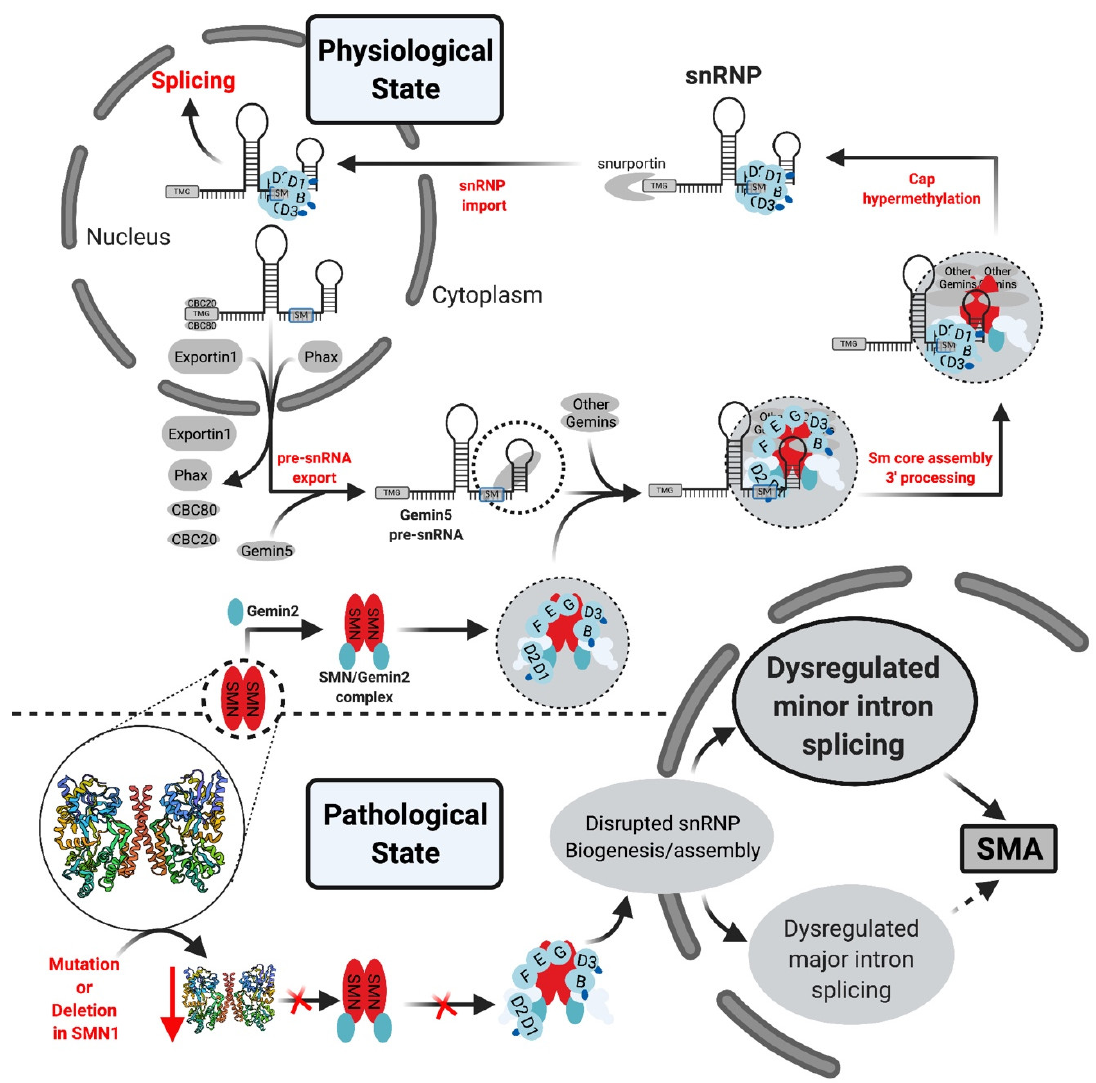
Figure 6. U snRNP biogenesis pathway. In the physiological state, once the U snRNA is transcribed and capped it associates with multiple factors which form the export complex and allow U snRNA export into the cytoplasm. Subsequently, in a process mediated by SMN complex and Gemin proteins, the Sm proteins interact with the U snRNA at the Sm site. The SMN complex dissociates, followed by 3′ processing/trimming and cap hypermethylation. The final product is imported into the nucleus. Further modifications occur on the U snRNA, and snRNP (U1, U2, U4, U5 or U11/U12, U4atac)-specific proteins associate with U snRNP Sm core [34].